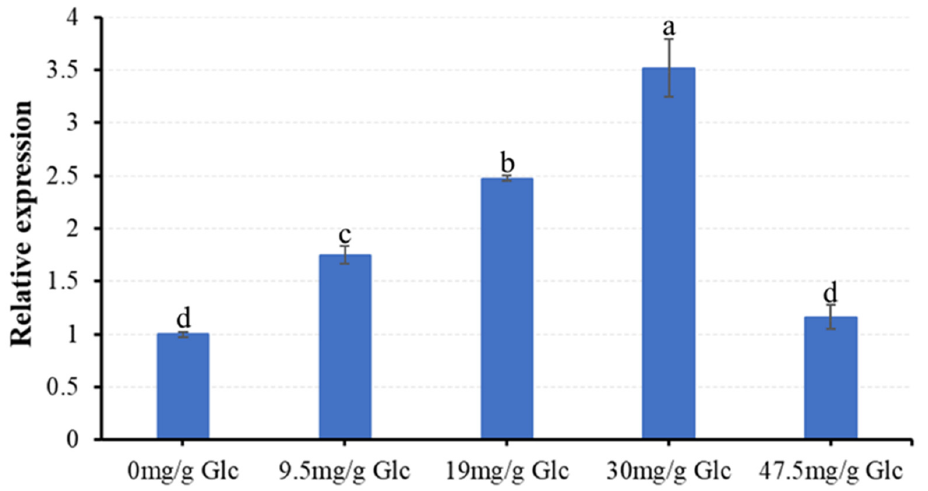
Figure 7. The expression level of VvGH9 in ‘41B’ wild-type calli treated with different concentrations of glucose. The letters above the bars indicated the significant differences by student’s t -test ( p < 0.05). Three biological replicates were analyzed, and the error bars represented the SD.